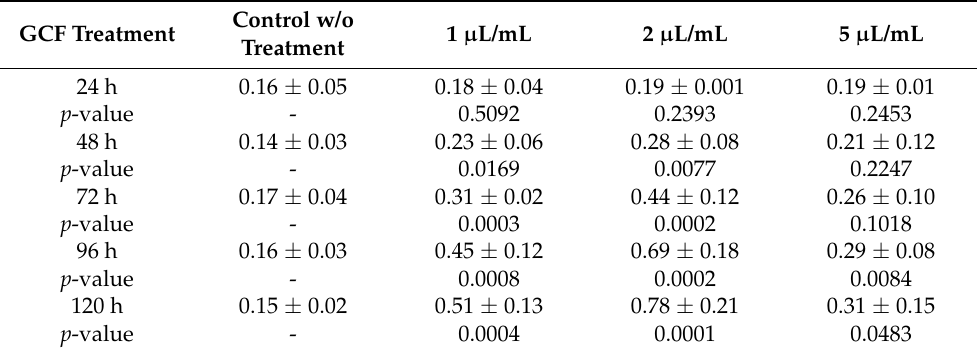
Table 5. Relative gene expression of LAG-3 in CD3+ T lymphocytes treated with different concentra- tions of GCF (Mean ±